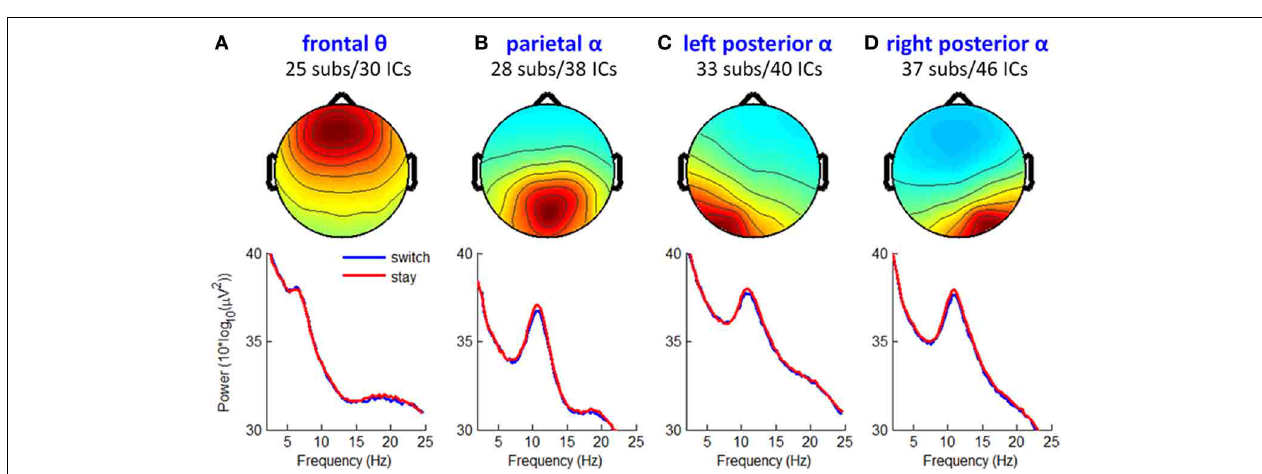
ERCOH differences between the two conditions based on paired t -tests ( p < 0 . 001). (B) This figure highlights the phase difference between the two IC clusters at time-frequency points where ERCOH magnitude in (A) is significant.